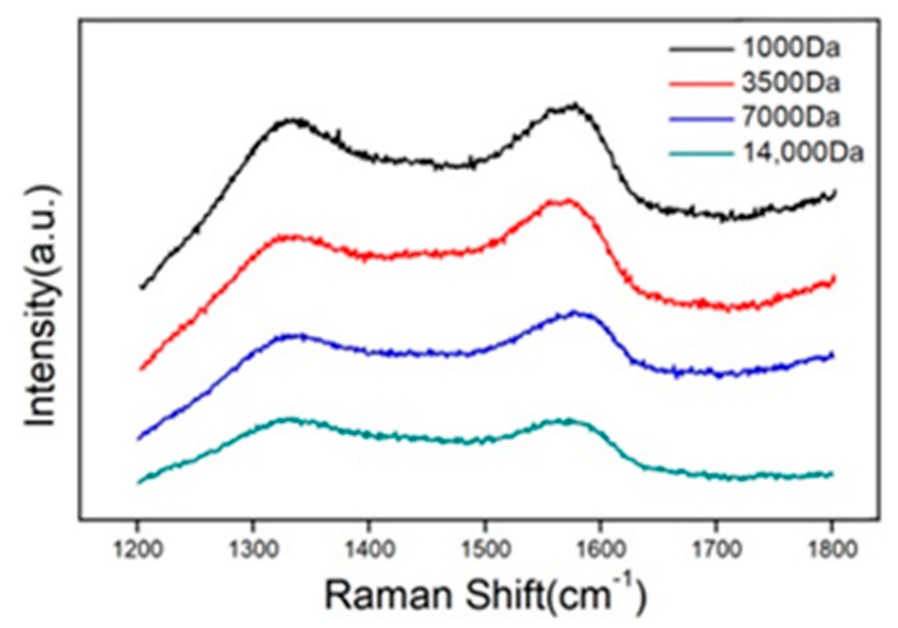
Figure 4. Raman spectra of the four separated GQDs. Table 1. D and G peak frequencies of the GQD samples obtained from dialysis bags of different molecular weights. D Peak Position Samples